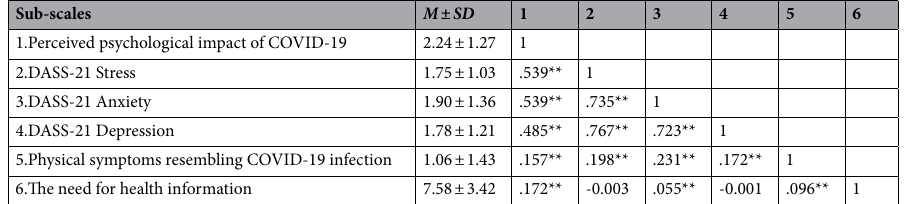
Table 1. Descriptive statistics and correlations of mean average score per item among subscales for all participants in 8 countries (N = 4612). † M refers to the mean average score per subscale. Mean average score = total score of subscale/number of items of a subscale. * p < 0.05, ** p < 0.01.